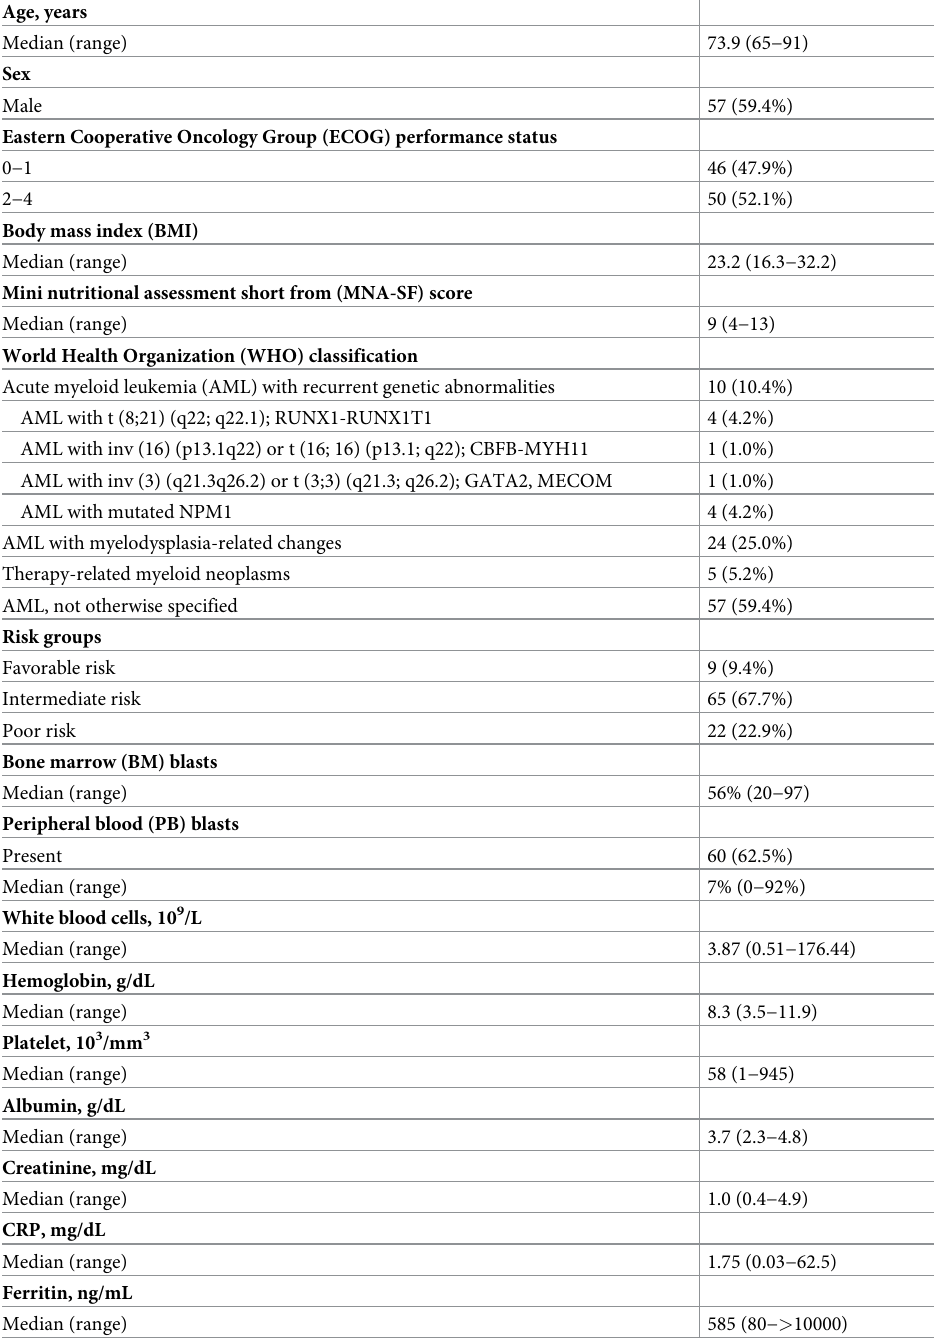
Table 1. Patient